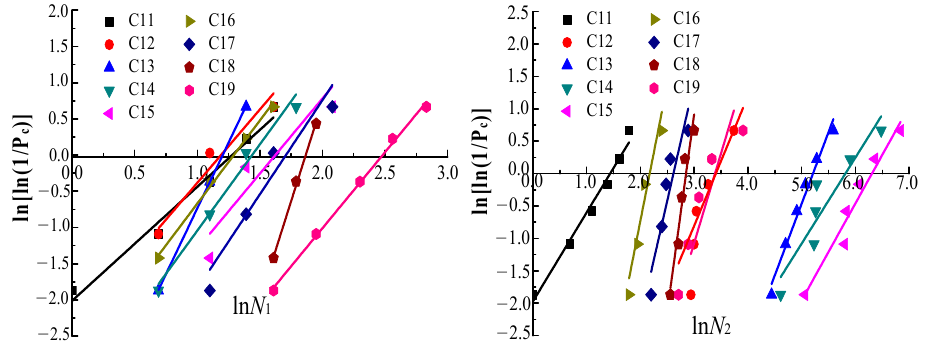
Figure 7. Linear regression of N 1 and N 2 in Weibull distribution for FRAC.